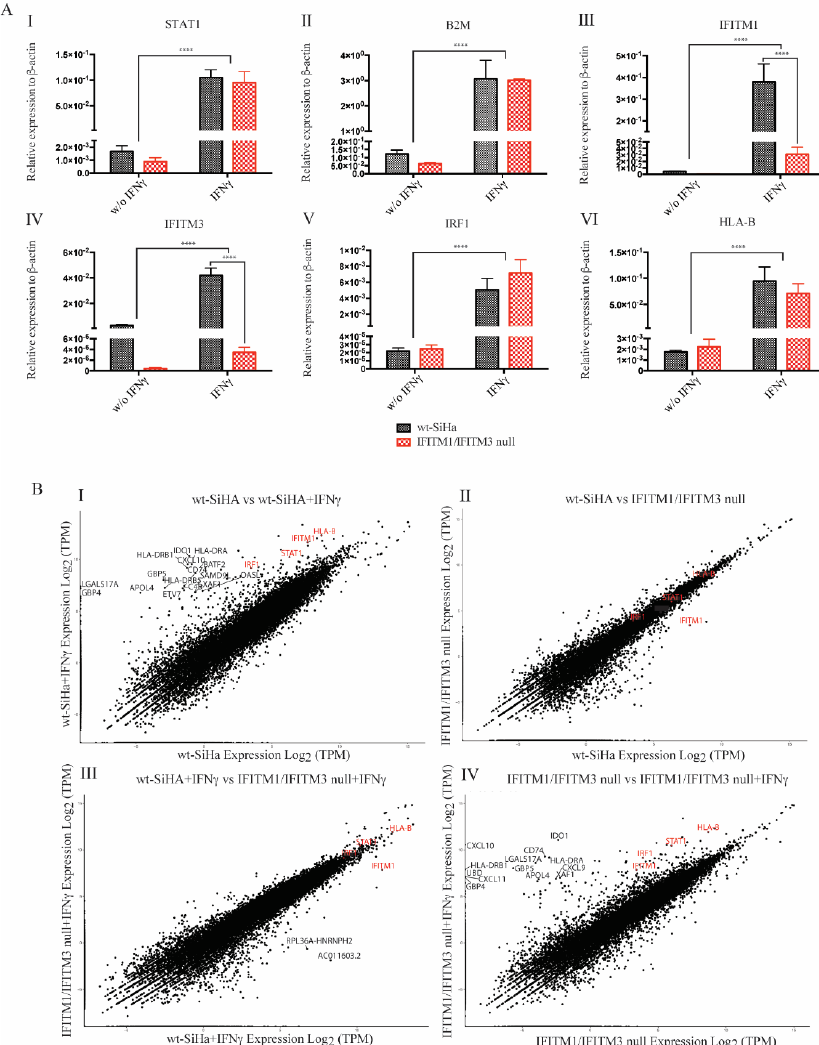
Figure 3. Validation of the transcript levels of IFN γ -stimulated genes in wt-SiHa cells and IFITM1/IFITM3 null cells, unstimulated or IFN γ -stimulated, for 24 h ( A ). STAT1 ( I ), B2M( II ), IFITM1 ( III ), IFITM3 ( IV ), IRF1 ( V ), and HLA-B ( VI ) mRNA was extracted and reverse transcribed into cDNA for quantification by RT-qPCR in wt-SiHa (in black) and IFITM1/IFITM3 null cells (in red). Measurements were performed in untreated cells and after stimulation with 100 ng/mL IFN γ for 24 h. Error bars are a representation of the variability between three biological replicates. Each biological sample was run in three technical replicates. β -ACTIN was used to normalize the mRNA expression between samples. Statistical study was performed with two-way ANOVA (**** p < 0.0001). ( B ) Comparison of total transcript count in wt-SiHa cells and IFITM1/IFITM3 null cells. Fastq files were imported into CLCBio Genomics workbench 12.0. The sequencing reads were used as